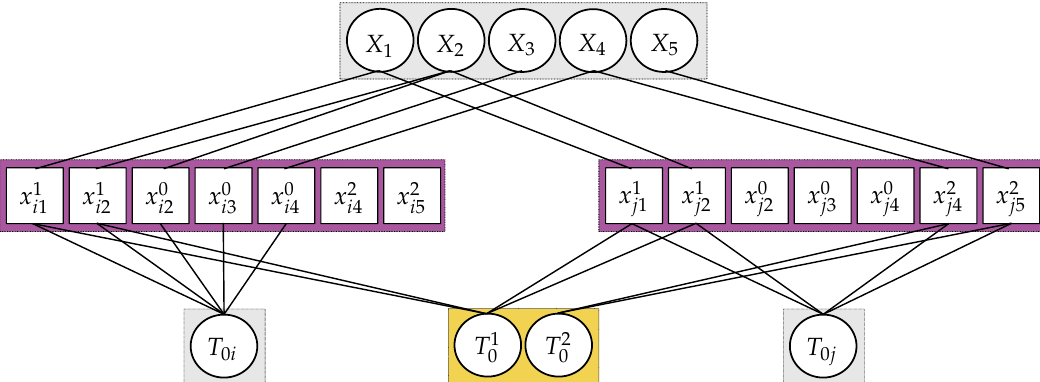
Figure 5. The graph model for the proposed method. Parameters to be optimized and measurements are represented as circles and boxes, respectively. This graph representaton is about Figure 4 at timestamp i and j . As mentioned, all the nonreference cameras’ keyframes are transformed into the corresponding trajectory of the reference camera. Considering the scenario in Figure 4b, we represent the graph by connecting the reference camera’s keyframes (the gray squares with a white circle), the extrinsic parameters (white circles in the yellow rectangle), 2D map points (white boxes in the purple rectangle), and 3D map points (white set of circles in the gray rectangle). If a map point is observed from a nonreference camera, we use both the corresponding extrinsic parameter and the reference camera’s keyframe for connection to the map points. In case a map point is observed from the reference camera, we then use only the reference camera’s keyframe for connection to the map